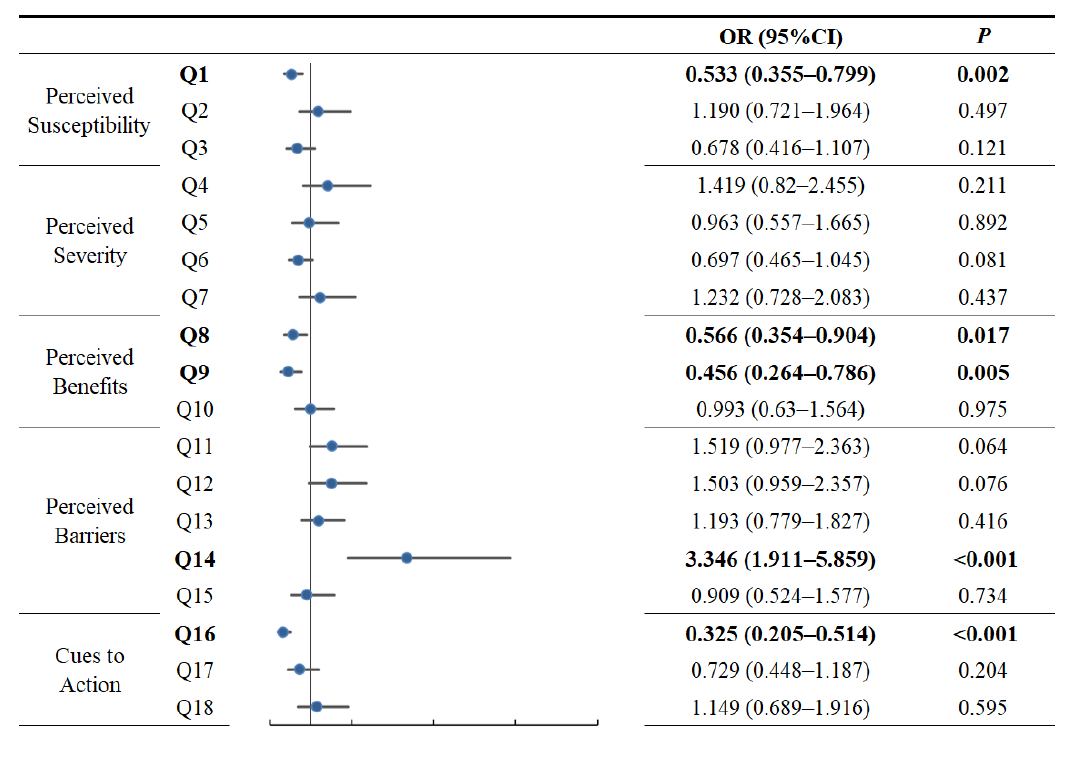
Figure 4. Adjusted Odds Ratio (OR) of comparing the rate of COVID-19 vaccine hesitancy within participants with different items. Statistically significant results ( p < 0.05) are in bold font.